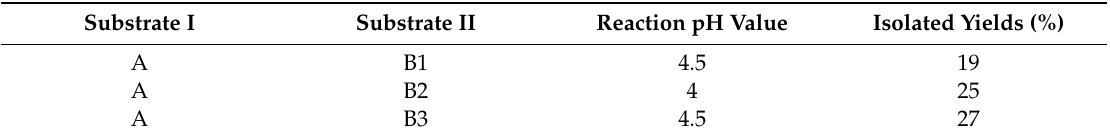
Table 2. Heteromolecular coupling reactions between substrate I (substrate A) and substrate II (substrate B1, B2 or B3), mediated by fungal LAC.